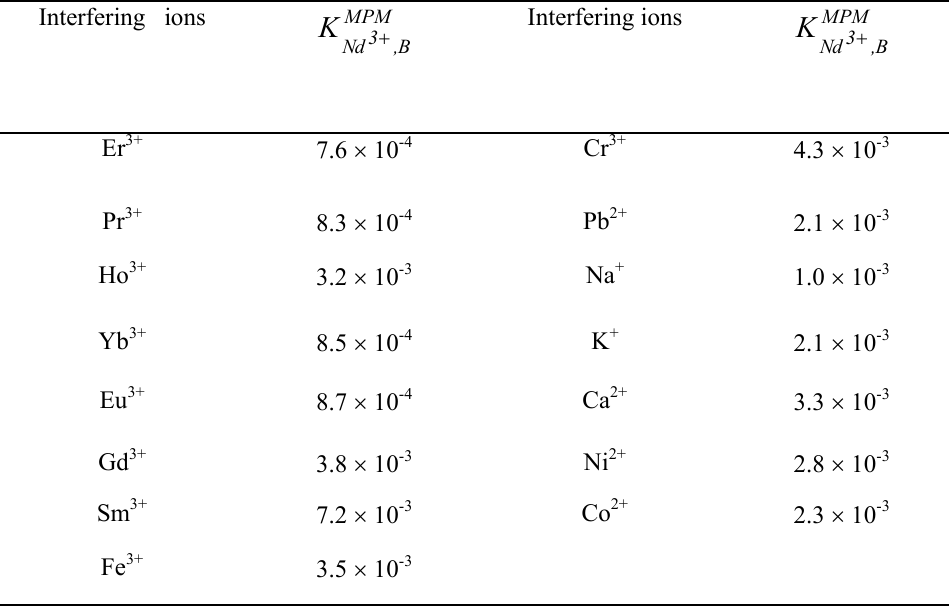
Table 2. Selectivity coefficients of various interfering